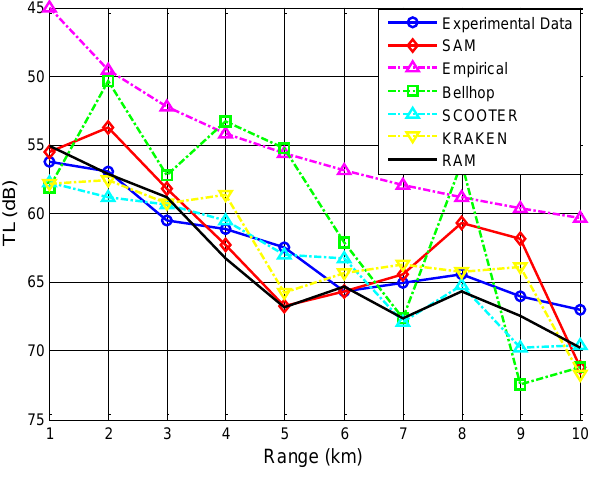
Figure 10. Transmission loss vs. range under different models in China